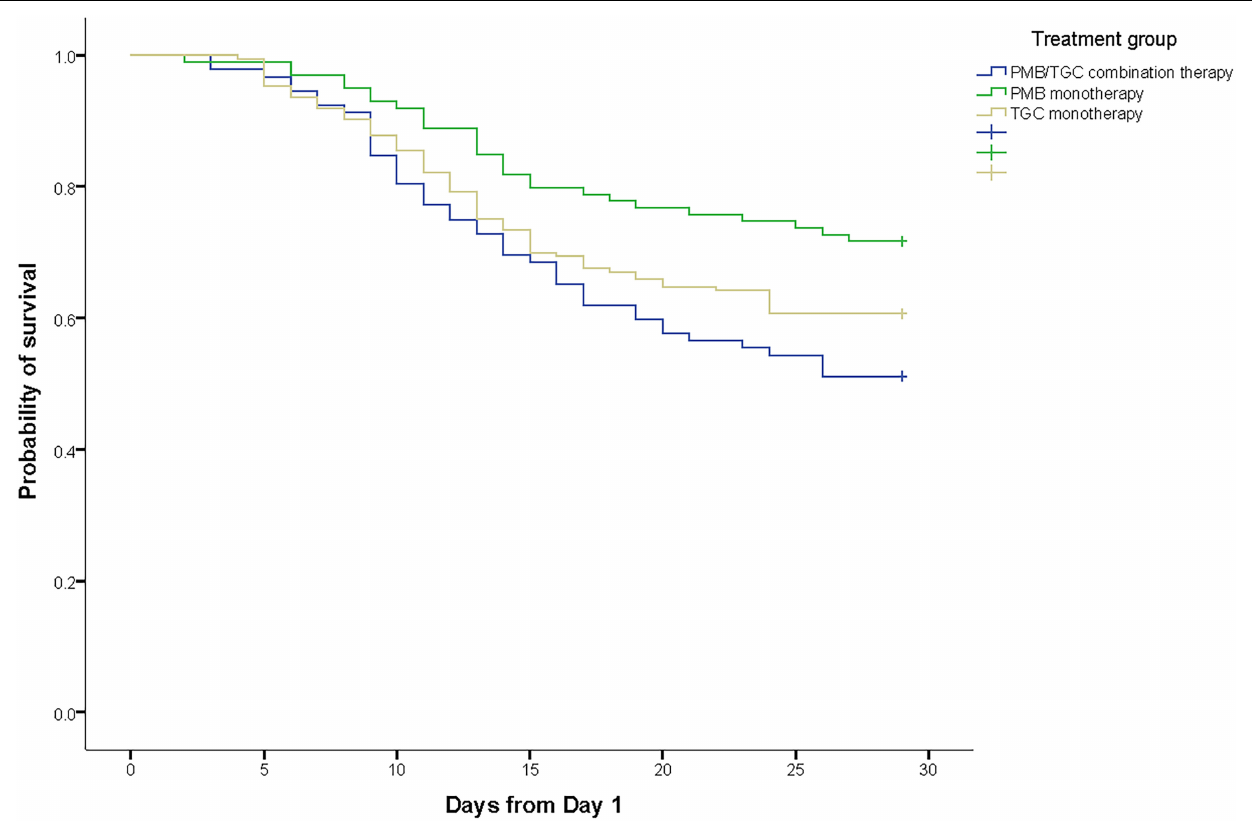
FIGURE 2 | Kaplan–Meier survival estimates of patients with hospital-acquired pneumonia due to carbapenem-resistant organisms in terms of polymyxin B and/or tigecycline